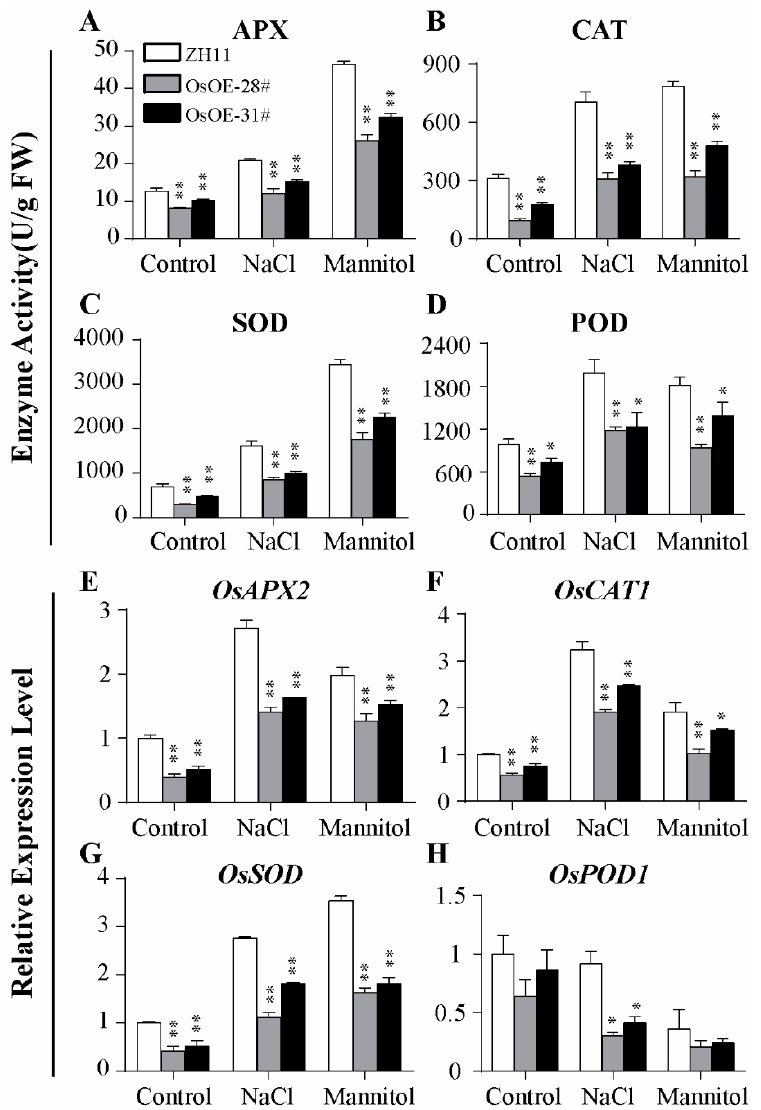
Figure 5. ROS scavenges enzyme activities of AcoMYB4 transgenic rice lines under osmotic stress. The water-cultured seedlings of OsOE-28#, OsOE-31#, and ZH11 at five-leaf age were transferred to a nutrient solution with or without 150 mM NaCl and 200 mM mannitol for 2 days. ( A ) APX, ( B ) CAT, ( C ) SOD, and ( D ) POD enzyme activity were directly determined from fresh leaves. The relative expression levels of ( E ) OsAPX2 , ( F ) OsCAT1 , ( G ) OsSOD , and ( H ) OsPOD1 were analyzed by qRT-PCR. The error bars indicate + SD ( n = 3 replicates). Asterisks indicate significant di ff erences for the indicated comparisons based on Student’s t -test (** p < 0.01; * p < 0.05). In addition, we analyzed electrolyte leakage, an important indicator of membrane injury, in the OE lines. The rice OE lines had higher electrolyte leakage than WT lines under salt and drought treatments, suggesting that the AcoMYB4 transgenic lines suffered from severe membrane damage. These results prompted us to investigate the membrane oxidation damage indexes (the content of